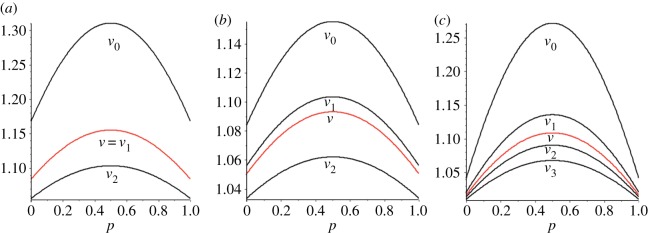
Communicability (V , in red) and associated vertex centralities (black) for dual circular flows: (a) (1,2,3) flow (note the communicability equals the v1 vertex centrality), (b) (2,3,5) flow and (c) (1,2,3,4) flow.